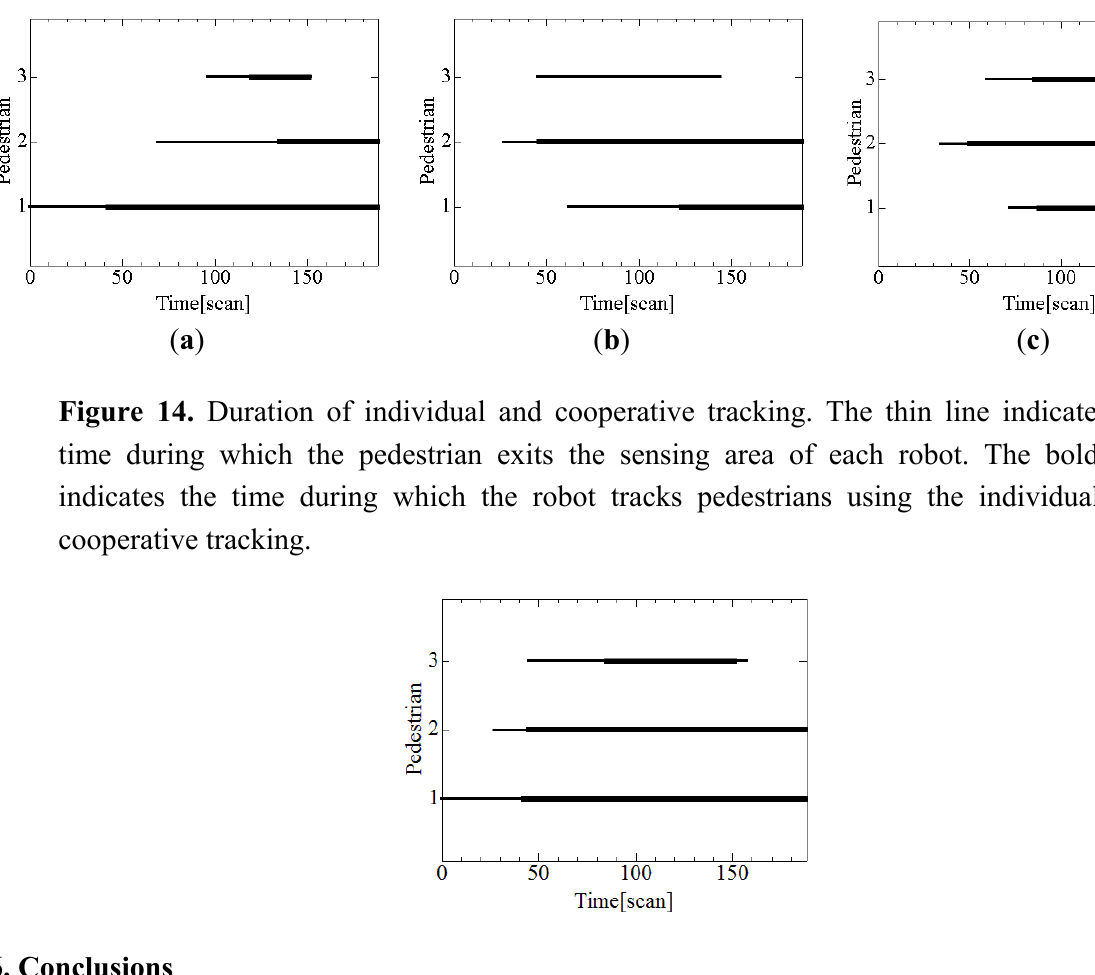
Figure 13. Duration of individual tracking. ( a ) Robot #1. ( b ) Robot #2. ( c ) Robot #3. The thin line indicates the time during which the pedestrian exits the sensing area of the robot. The bold line indicates the time during which the robot tracks pedestrians using the individual tracking.